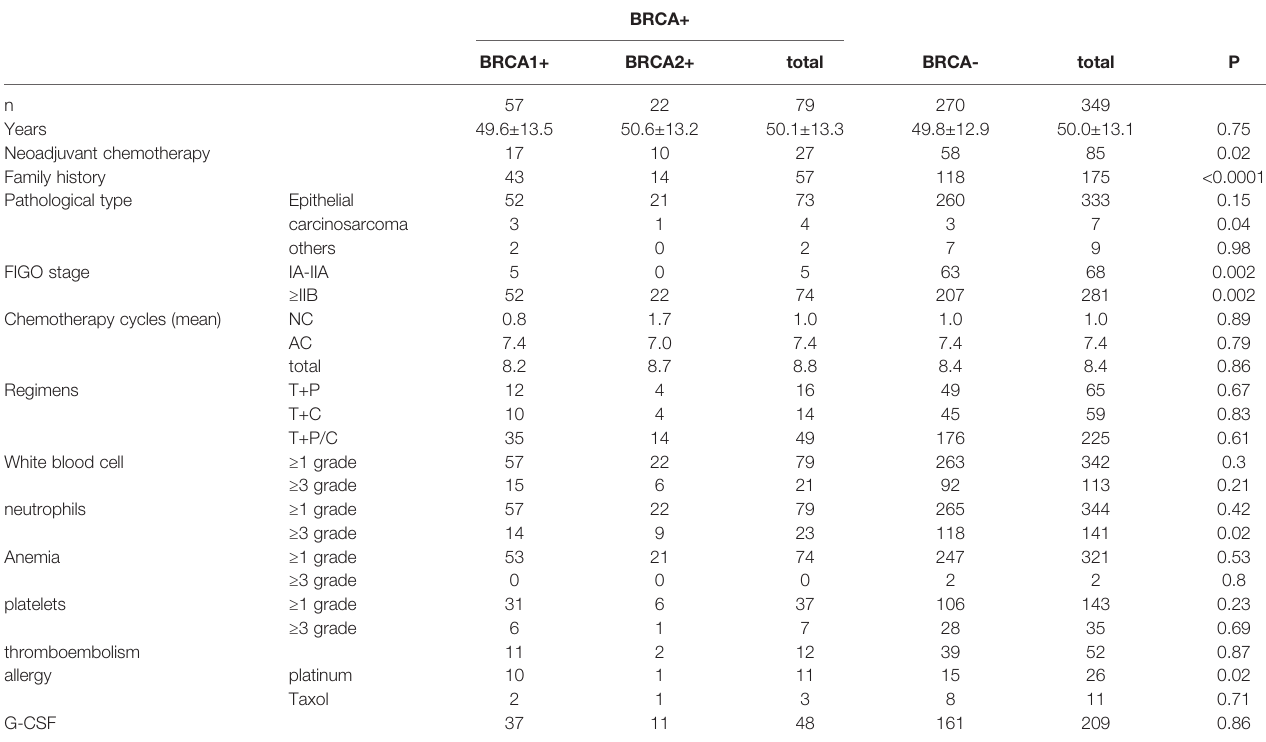
TABLE 1 | Basic characteristics of research